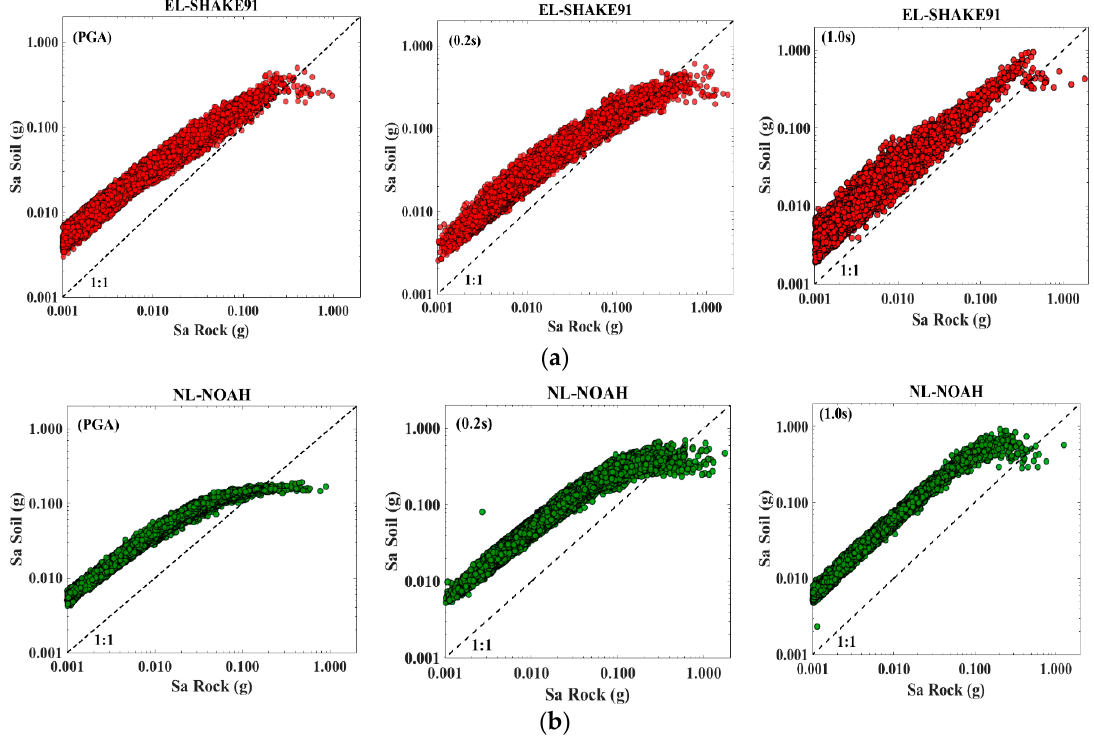
Figure 12. Spectral acceleration on soil Vs. Spectral acceleration on rock, for three different spectral periods (PGA, 0.2 s and 1.0 s); ( a ) Equivalent-linear (EL) results (SHAKE91); ( b ) Non-linear (NL) results (NOAH).